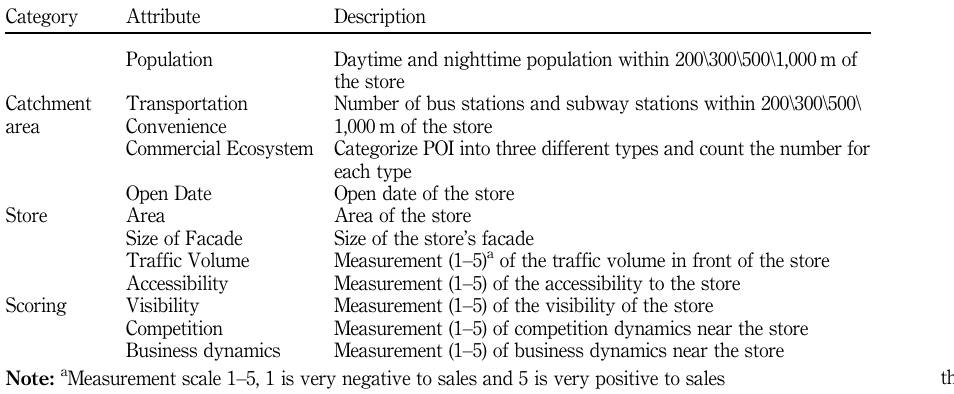
Table II. Input data